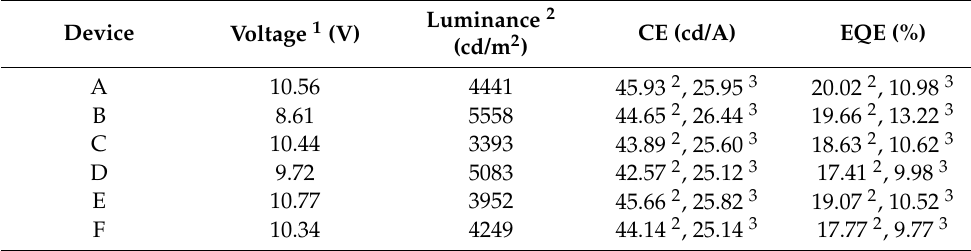
Table 2. Summary of OLEDs performances including driving voltage, luminance, CE and EQE.